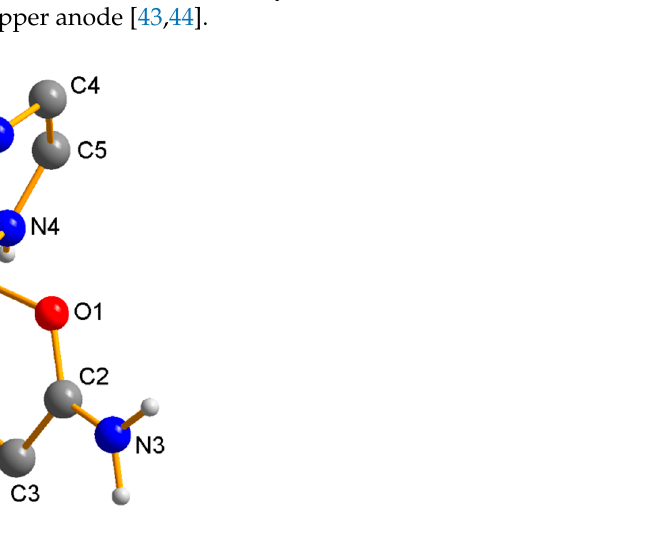
Figure 3. Asymmetric unit of isostructural IFPs in general, showing the coordination environment of the metal center and the bridging mode of inter-connecting Linker L.